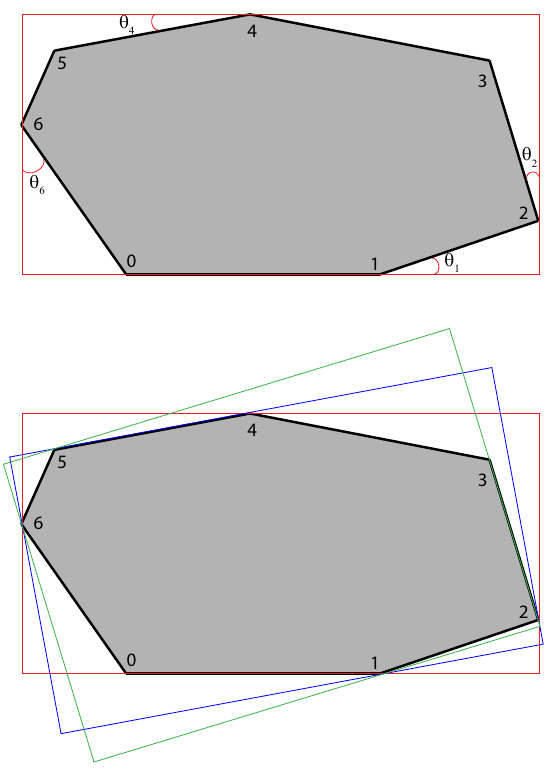
Figure 9. Top : Initial bounding-box encompassing a polygon. Bottom : 3 rotations of the